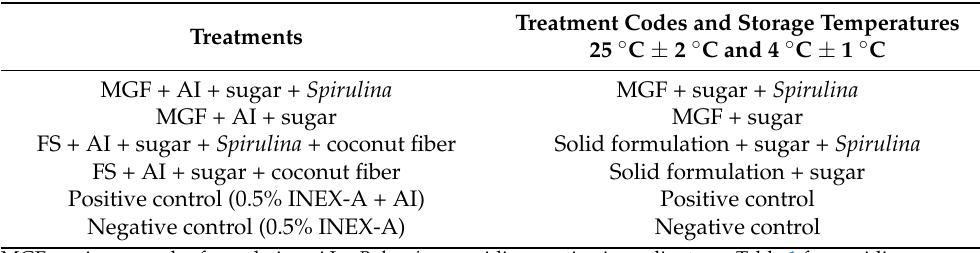
Table 2. Beauveria bassiana conidia shelf-life on microgranular formulations after storage at 25 ◦ C and 4 ◦